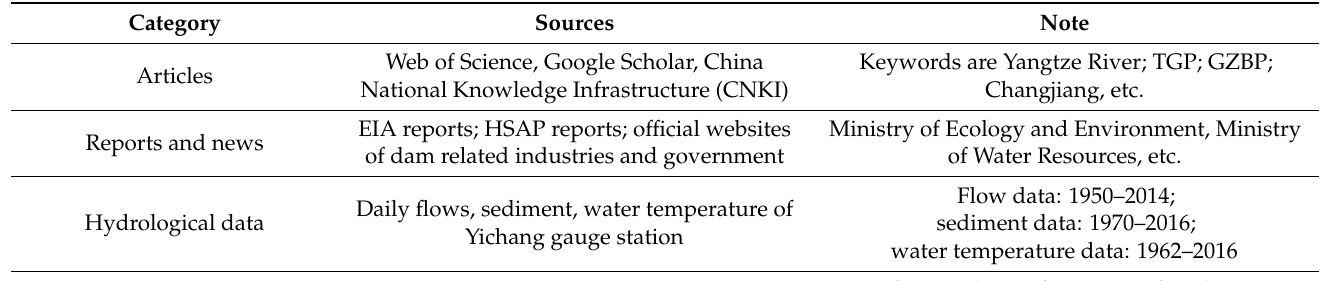
Table 4. Data category and sources for